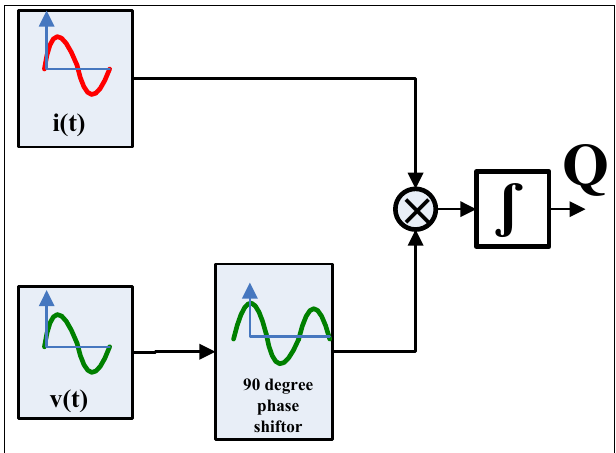
Figure 2. Time shift approach for reactive power